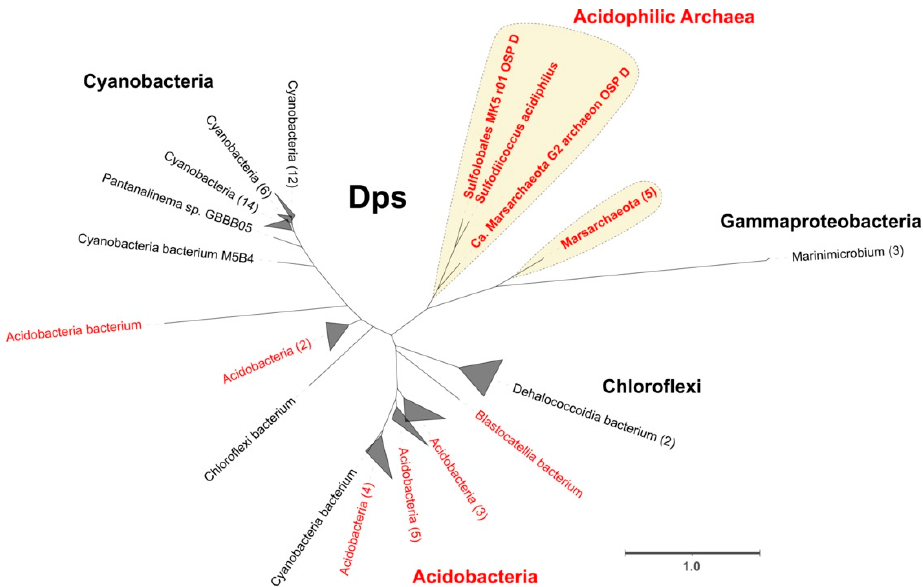
Figure 3. Phylogenetic tree from predicted protein sequences of DNA-binding protein from starved cells (Dps). The protein sequences from acidophilic archaea are indicated with a yellow background. In red letters are the sequences associated with acidophiles. Collapsed branches show the number of genomes in each clade in parenthesis after the names. Scale bar represents 1 amino acid substitution per site.